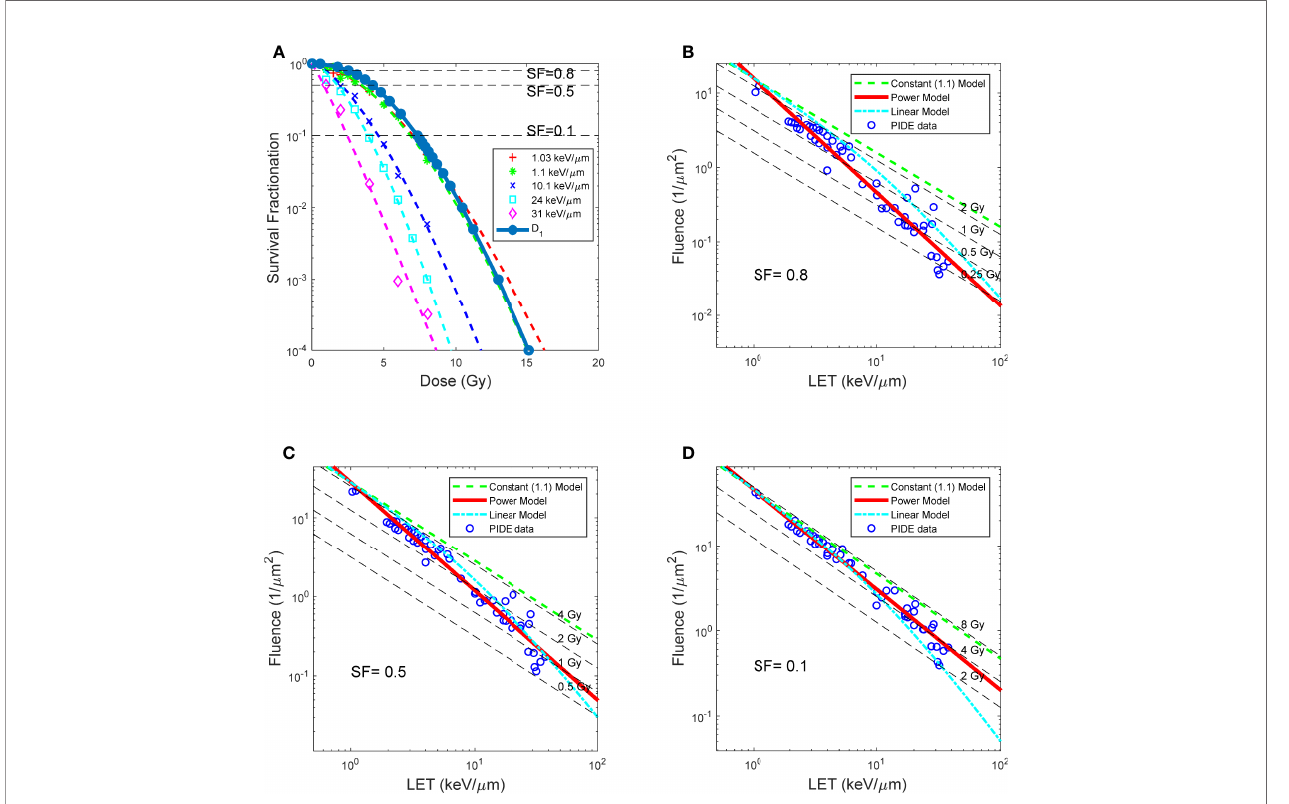
FIGURE 3 | BE as a function of LET, for asynchronized V79 cell irradiations with proton. (A) Dose response curves of protons with different LET, and survival as a function of D1. (B – D) LET and fl uence needed for proton beams to achieve SF 0.8, 0.5 and 0.1, respectively. RBE models prediction overlay with measured data. Red solid lines: RBE calculated using LET power model (Eq. 7). Green dash lines: constant (1.1) RBE model (Eq. 8). Cyan dash lines: linear RBE model (Eq. 9). Data points: RBE calculated using reported experiment results complied in PIDE, total of 278, detailed in Table 1